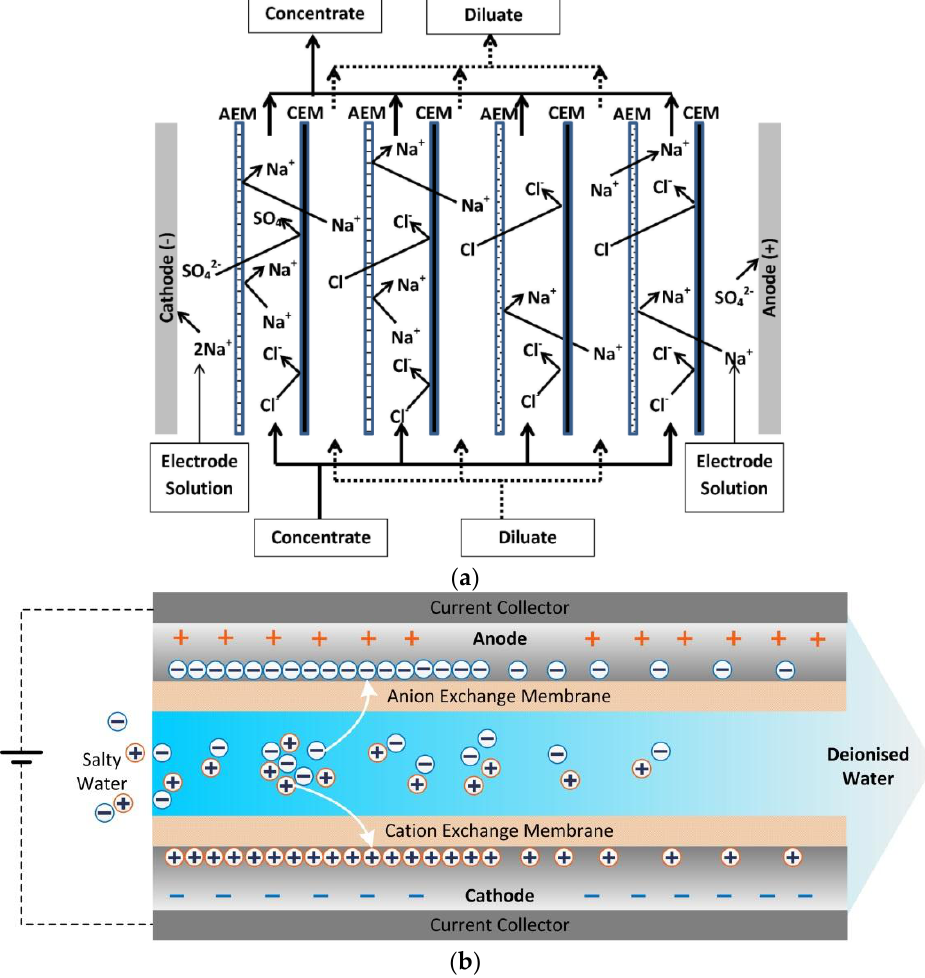
Figure 1. ( a ) Electrodialysis (adapted from [9]); and ( b ) Membrane Capacitive Deionisation (MCDI) during adsorption.